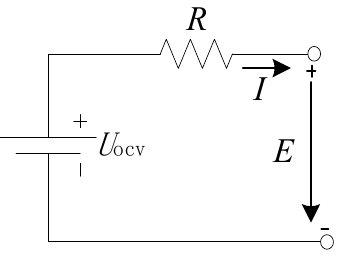
Figure 1. Rint equivalent circuit model.